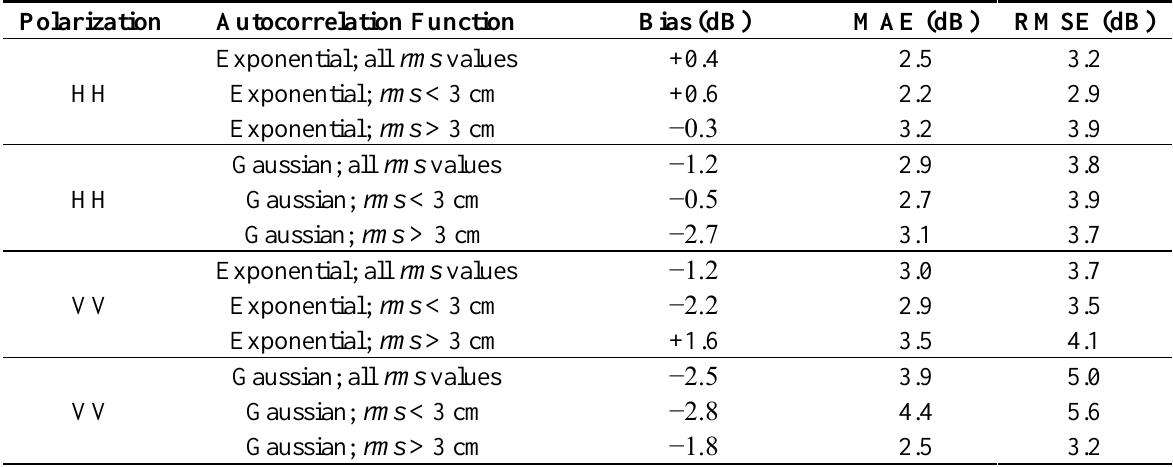
Table 2. Statistics for the evaluation of Integral Equation Model (IEM). Bias = SAR–IEM; MAE = Mean Absolute Error; RMSE = Root Mean Square